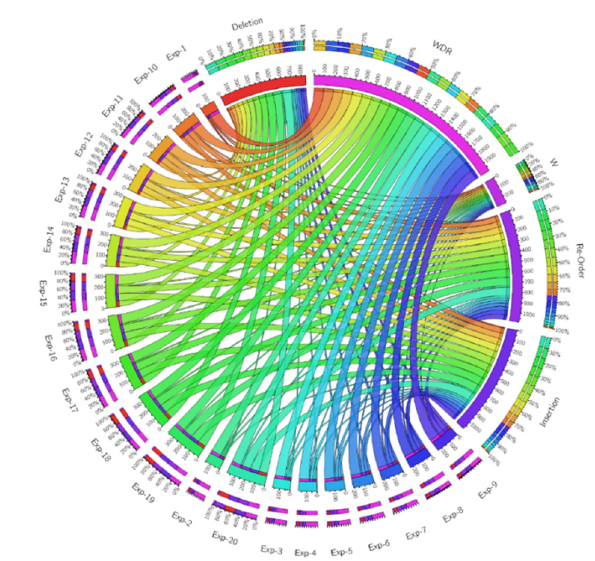
Fig. 10: Insertion, Deletion and Re-Ordering